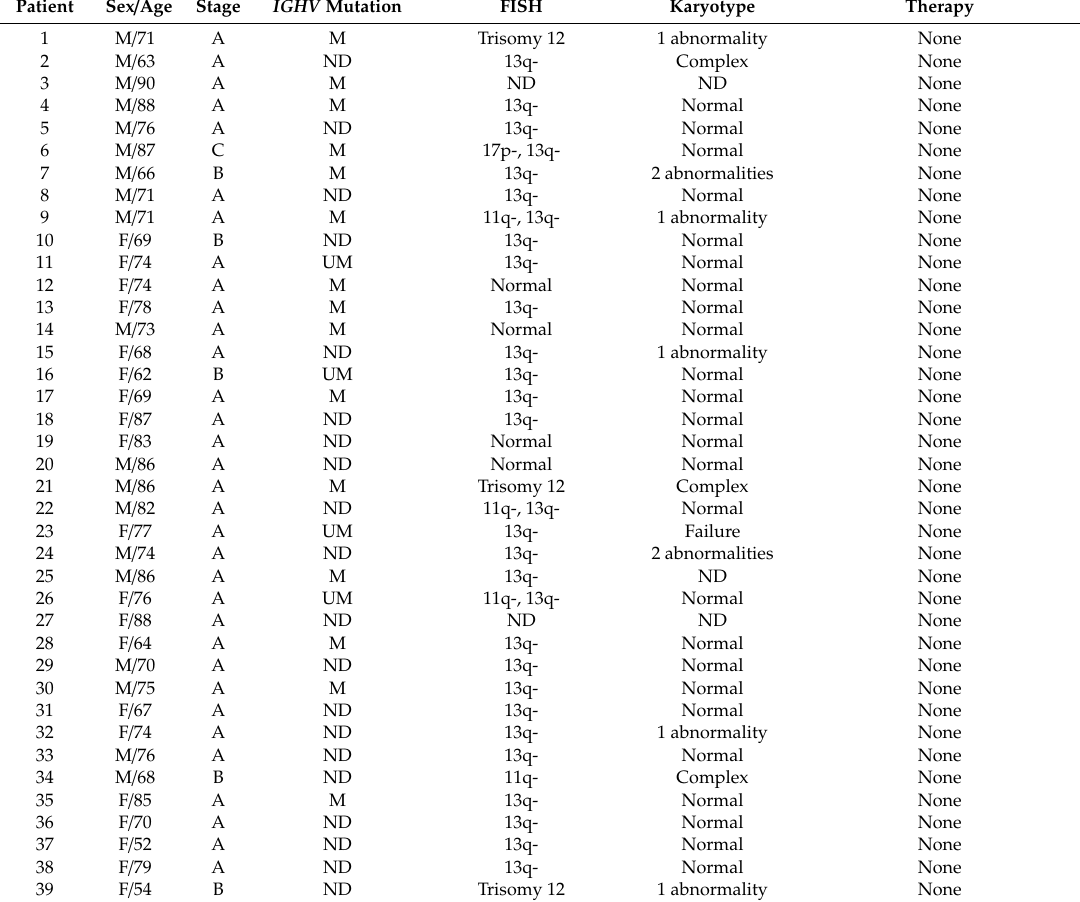
Table 1. Clinical characteristics of chronic lymphocytic leukemia (CLL)